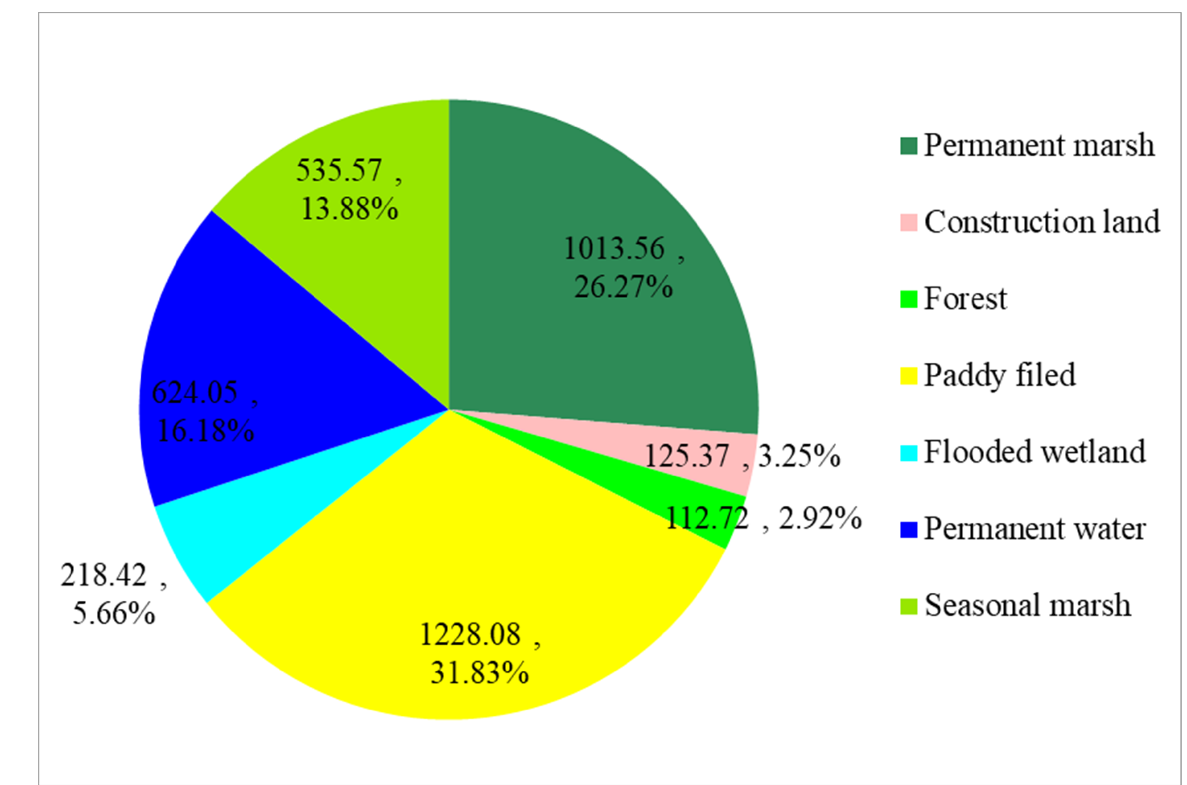
Figure 6. Area ratio of each land cover type in 2020.